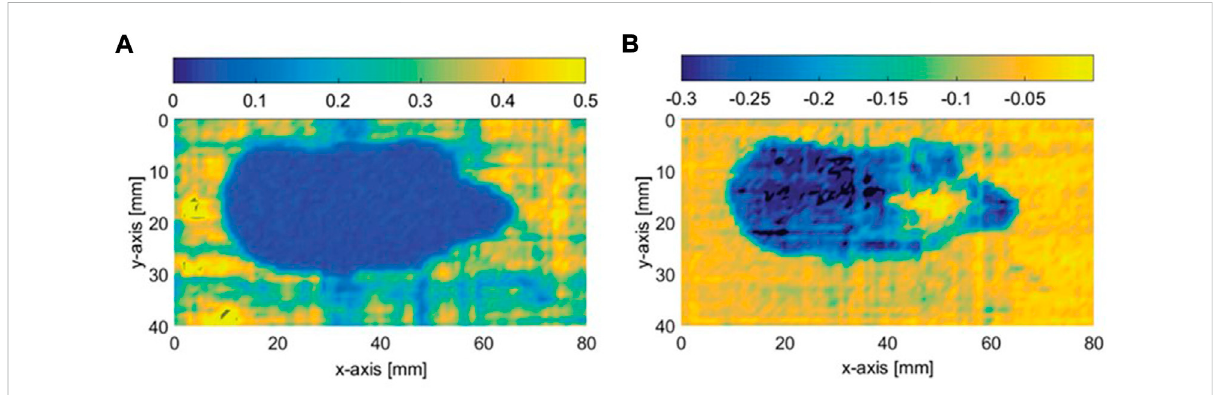
FIGURE 5 Color-coded ultrasonic C-scan images of impact-indued damage CFRP specimen with thickness of 2 mm: (A) double-through transmission; (B) pulse re fl ection (Fromme et al.,